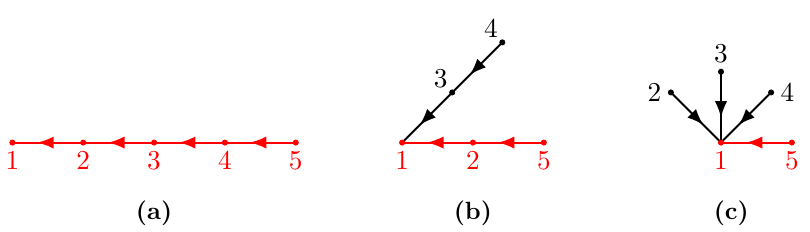
Figure 1 . Examples of trees with various IT memberships: (a) a tree that only belongs to IT(1 , 2 , 3 , 4 , 5) , (b) a tree that belongs to all IT(1 , (2) (cid:1) (3 , 4) , 5) , (c) a tree that belongs to IT(1 , β, 5) for all β ∈ S . The baselines are shown in red here and in all future occurances. { 2 , 3 , 4 } where the coefficients N (1 , β, n ) are the DDM basis numerators. They are associated with half-ladder diagrams, and are the master numerators for the BCJ tree relations. A given